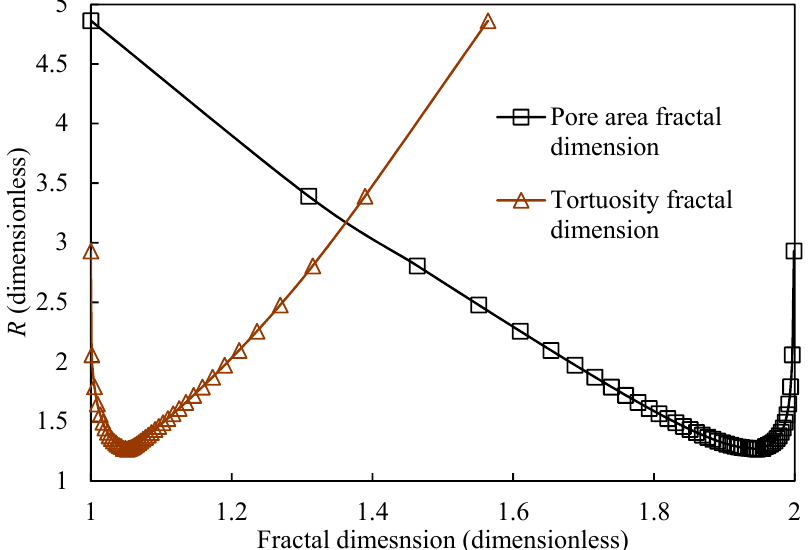
Figure 11. The relationship between the fractal dimension and the permeability difference coefficient ( R ).